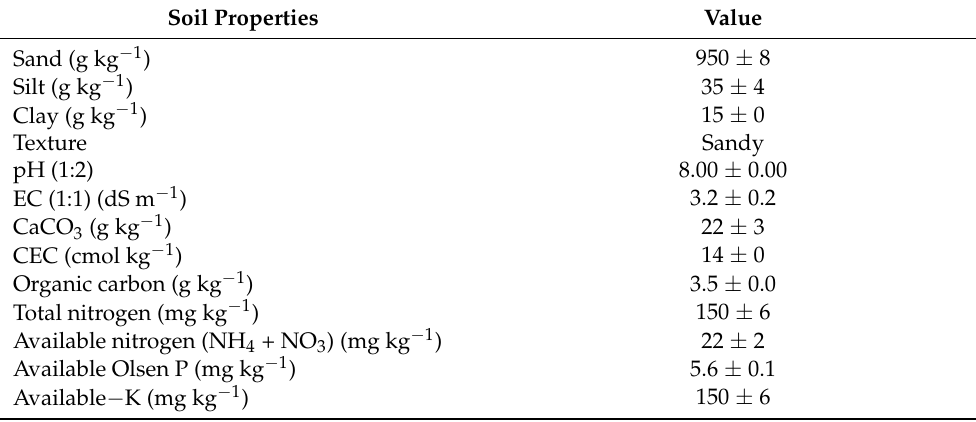
Table 1. Main properties of the studied